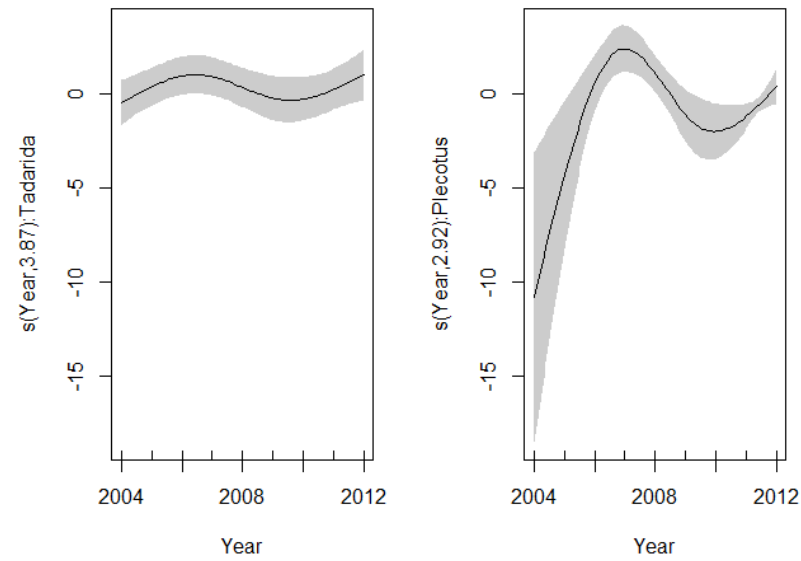
Figure 3. Spline fit (solid line) with 95% confidence interval (dashed lines) of the variability in the EBLV-1 seroprevalence as a function of years (GAM: EBLV-1-antibody prevalence ~ intercept + s(year, by = P. austriacus ) + s(year, by = T. teniotis )). ( Left ) T. teniotis ; ( right ) P. austriacus